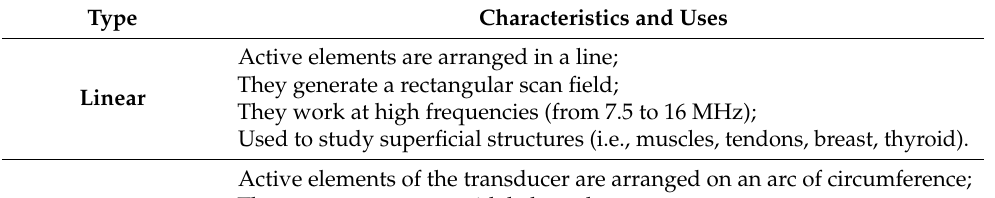
Table 2. Different types of ultrasound probes with their characteristics and uses. Type Characteristics and Uses Active elements are arranged in a line; They generate a rectangular scan field; Linear They work at high frequencies (from 7.5 to 16 MHz); Used to study superficial structures (i.e., muscles, tendons, breast, thyroid). Active elements of the transducer are arranged on an arc of circumference; They generate a trapezoidal-shaped scan area; Convex They work at medium and low frequencies (from 3.5 to 5 MHz); Used for the study of deeper structures (i.e., visceral organs). Active elements are aligned in a short band or rectangle configuration; They generate a fan-shaped beam; Sectorial They work at low frequencies (from 2 to 3.5 MHz); Usually used for cardiac examination. They can be linear or convex; Endocavitary Used for intrarectal or intravaginal examinations; They work at medium frequencies (from 5 to 7.5